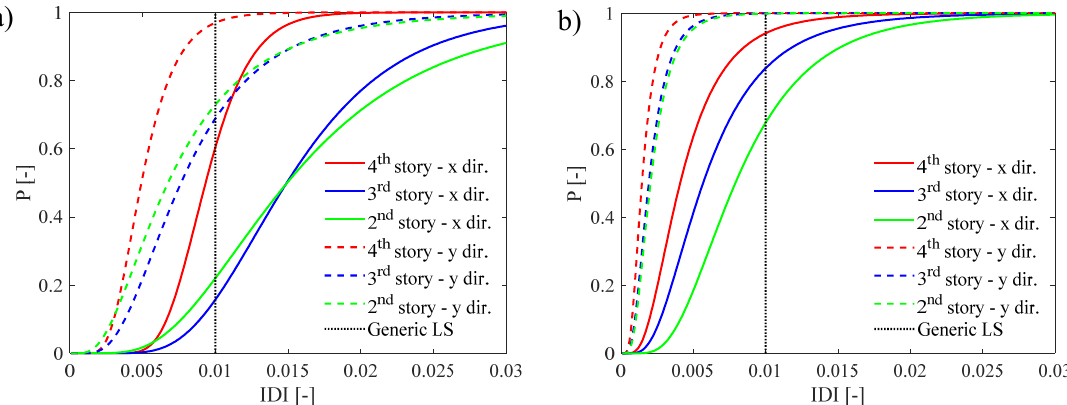
Figure 13. Lognormal monovariate CDFs for the IDIs in X and Y direction: FB model ( a ), BI model ( b ).